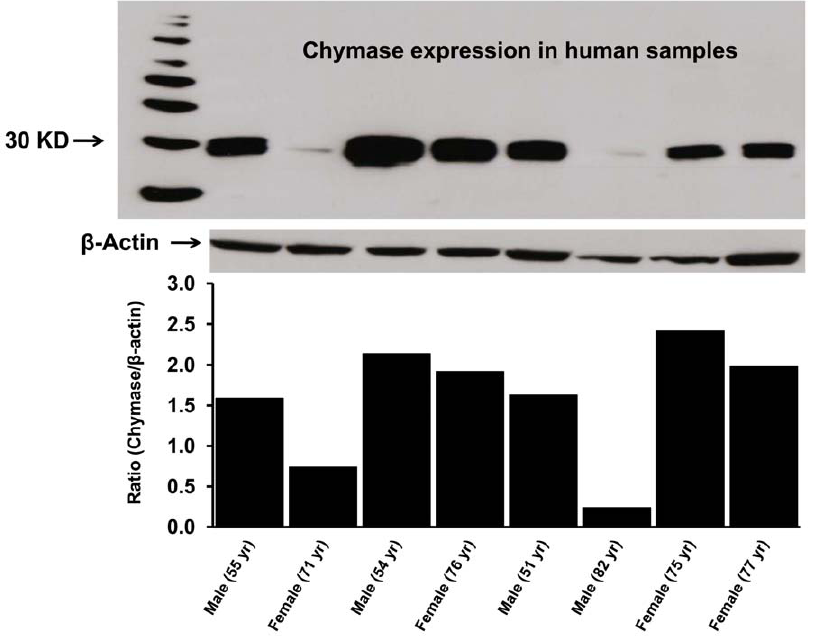
Figure 4. Chymase protein expression in human atrial tissue. Chymase protein expression in human atrial samples was analyzed by western blotting using a primary monoclonal anti-human chymase antibody (CMA1 antibody from R&D System, Cat # MAB-4099; 2 m g/mL). The plasma membrane (50 m g protein) were separated by gel electrophoresis and transferred on PVDF. Equal protein loading on each lane was confirmed by b - actin detection (1:5,000 dilution). Level of protein expression was shown as relative O.D. ratio (chymase/ b -actin) for each human sample.